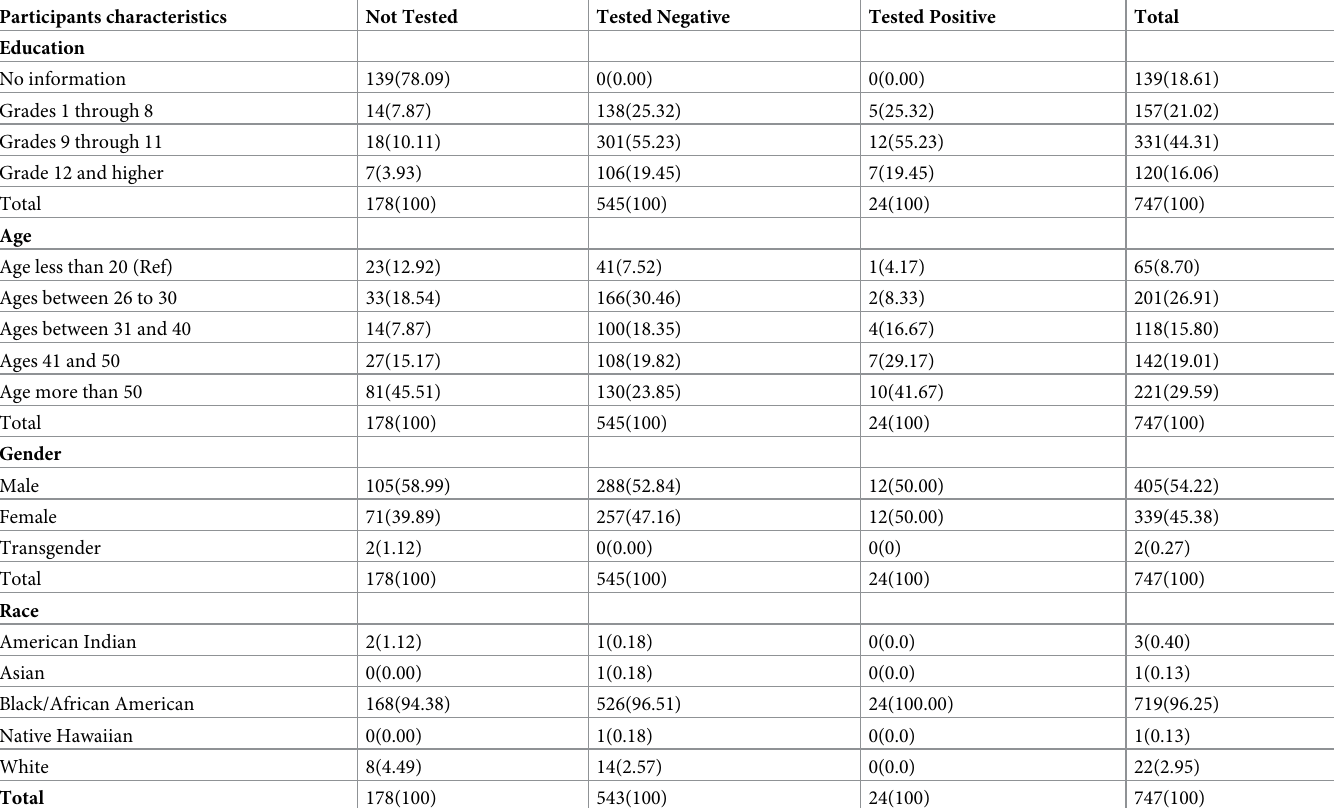
Table 1. Descriptive characteristics of NHBS HET 4 cycle DC by HIV